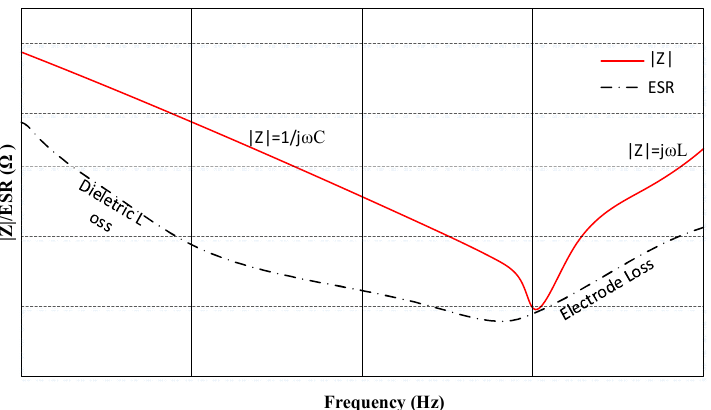
Figure 14. Behavior of the capacitor impedance as a function of the operating frequency and ESR.